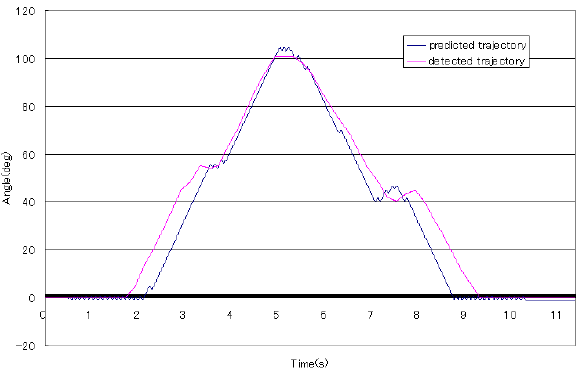
Figure 20. The typical elbow flexion and extension for S2.